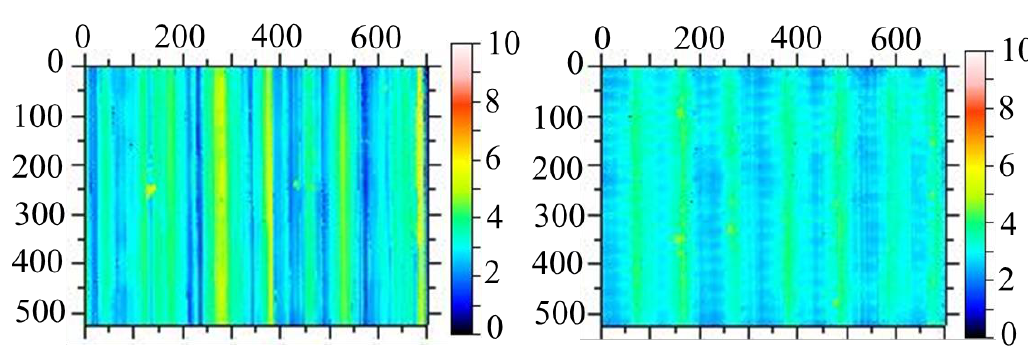
Figure 14. Optical scans of machined surfaces.